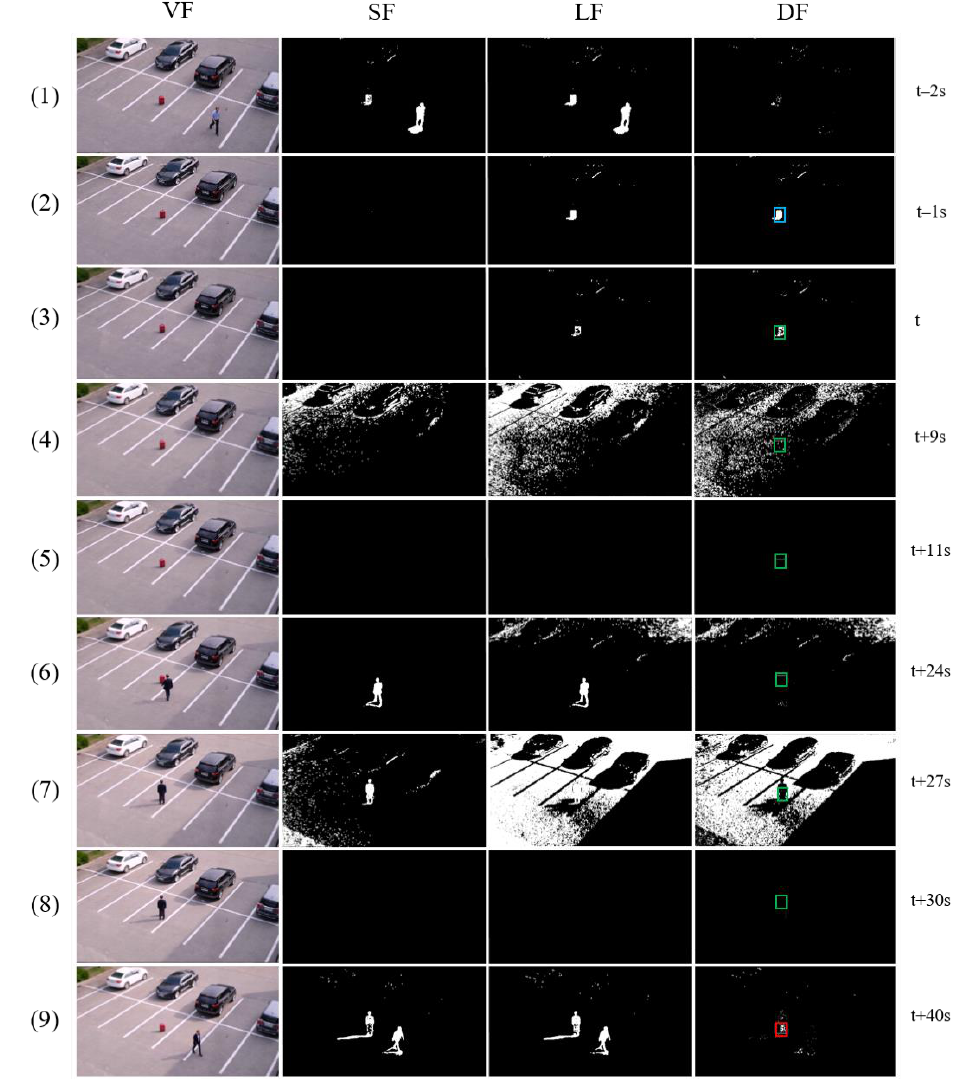
Figure 8. Outdoor illumination changes in KICV (Koreatech illumination change video) video 1.